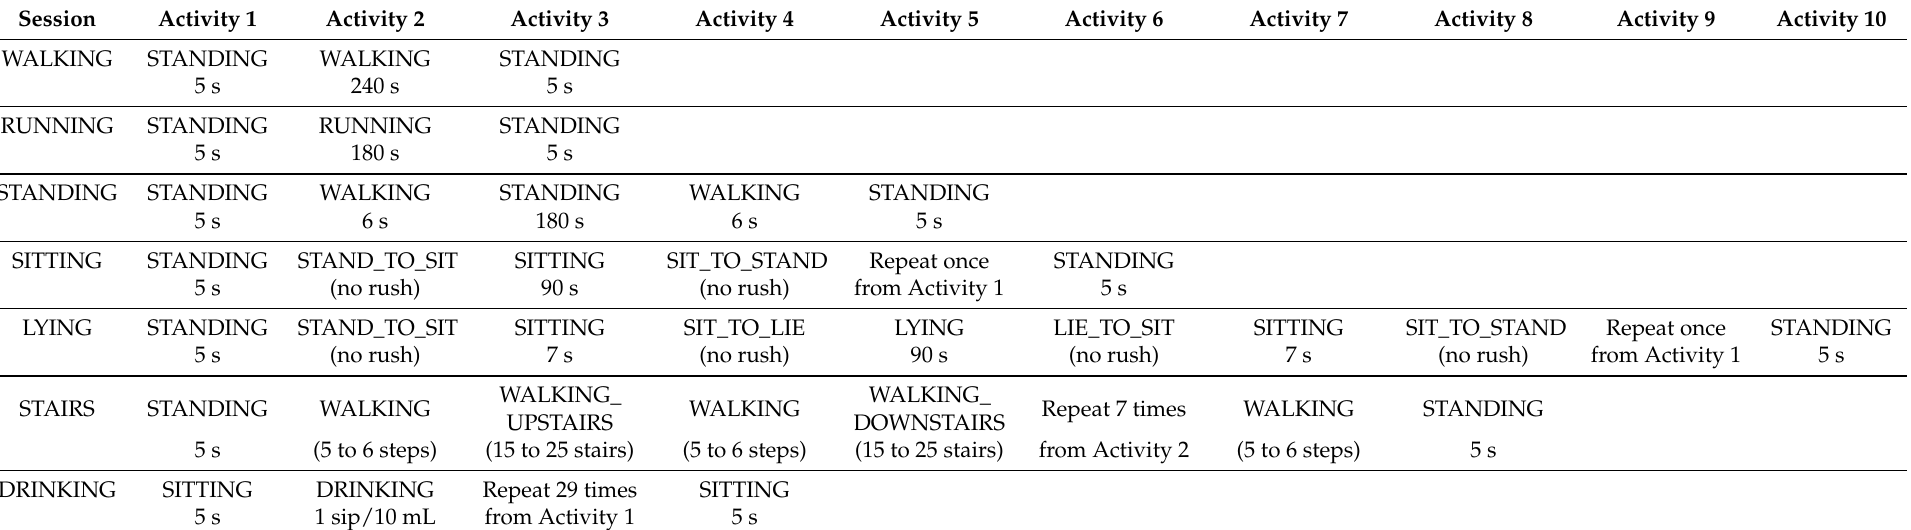
Table 1. Instructions for each session of activity